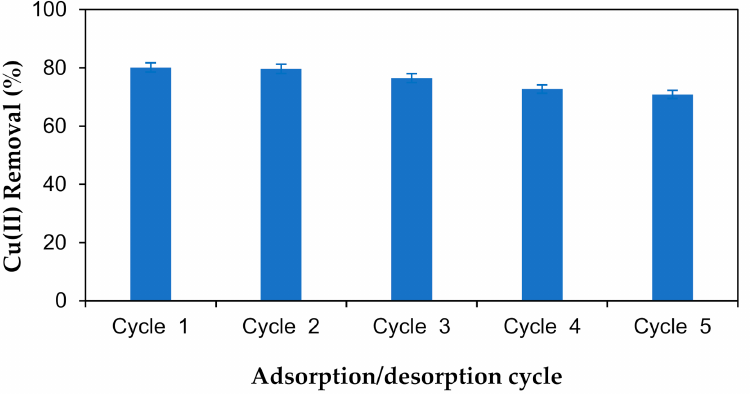
Figure 13. Determination of the reusability potential of M-OPEFB-CNF composite as a biosorbent for Cu(II)